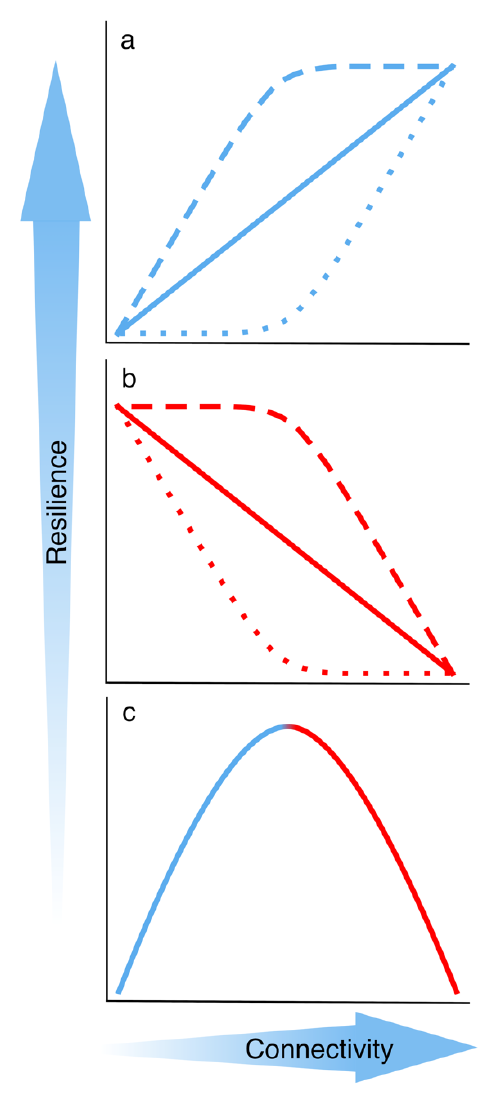
Figure 4. Conceptual models illustrating three examples of how an ecological function (e.g., herbivory as tested in this study) may respond to increasing levels of connectivity. The function can respond either positively ( a ) or negatively ( b ) to increased connectivity, either linearly (sold line) or exhibiting an upper (dashed line) or lower threshold (dotted line). A unimodal response curve ( c ) could occur where a function (or multiple functions) responds initially positively to more connectivity but declines beyond a certain threshold of connectivity. Positive relationships are indicated with blue lines and negative relationships with red lines.